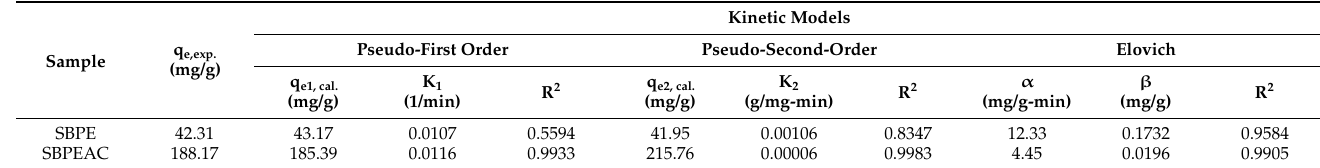
Table 3. Non-linear kinetic model parameters for MG adsorption on adsorbent